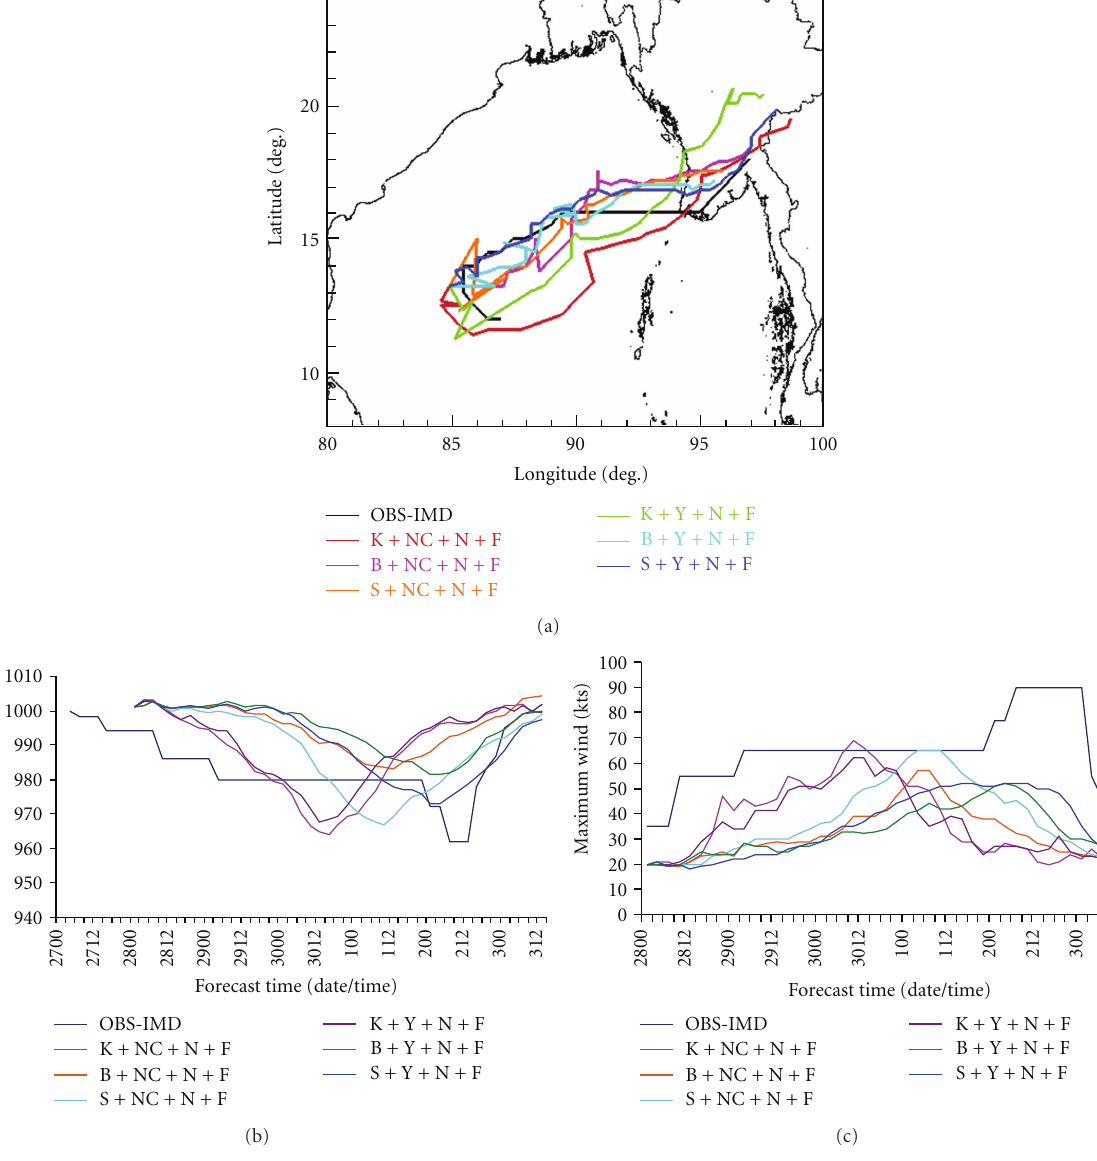
Figure 3: (a) Track, (b) MSLP (hPa), and (c) maximum wind (kts) of the cyclone NARGIS with three best cumulus convections, 2 di ff erent PBL, NMM land surface, and Ferrier microphysics